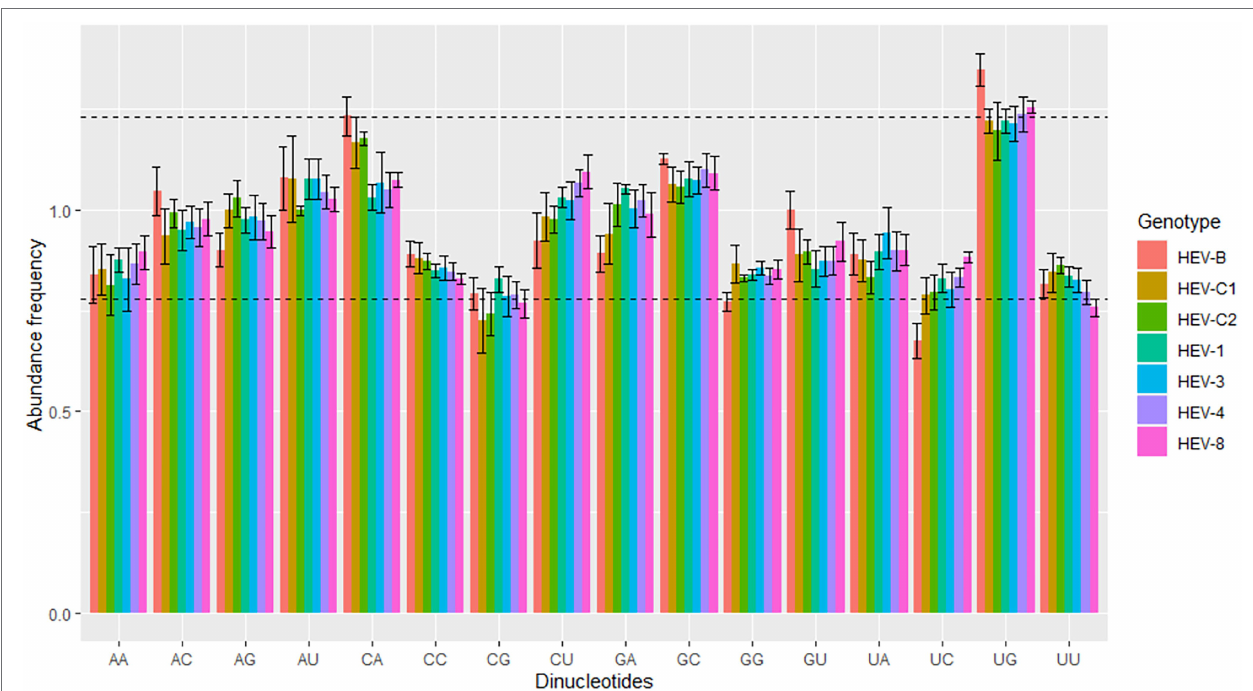
FIGURE 2 | Dinucleotide abundance frequency based on the HEV complete coding sequences. The dashed lines showed overrepresented and underrepresented values. Seven HEV genotypes were presented by